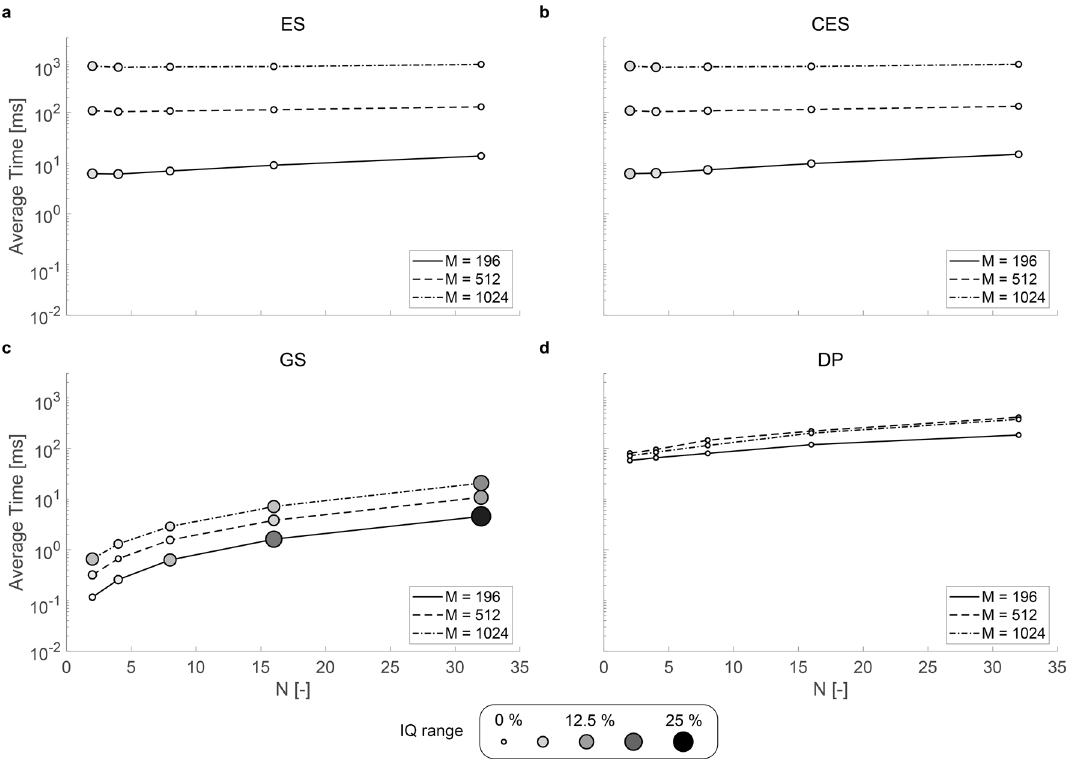
Figure 4. Comparing the average computational time for solving one geometry using each solver. The sample size is 1000 geometries, and solved the same dataset as in Fig. 3. The magnitude of IQ range from Fig. 3 is transposed to the marker size and darkness. Small, white marker indicates low IQ range; large dark marker indicates high IQ range. ( a ) Eigensolver (ES), ( b ) corrected Eigensolver (CES), (c) GS-PAT (GS) and (d) Diff- PAT (DP). ( a )–( c ) were based on a C + + code, where ( d ) was run on Python. The performance was evaluated on the same desktop computer. Image created using MATLAB 2020a Update 4 (https:// www. mathw orks. com/ downl oads/) and Adobe Illustrator 24.2.1 (https:// www. adobe. com/ produ cts/ illus trator.